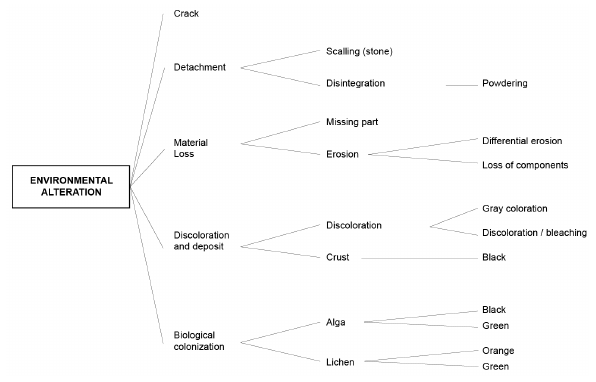
Figure 11. Environmental alterations